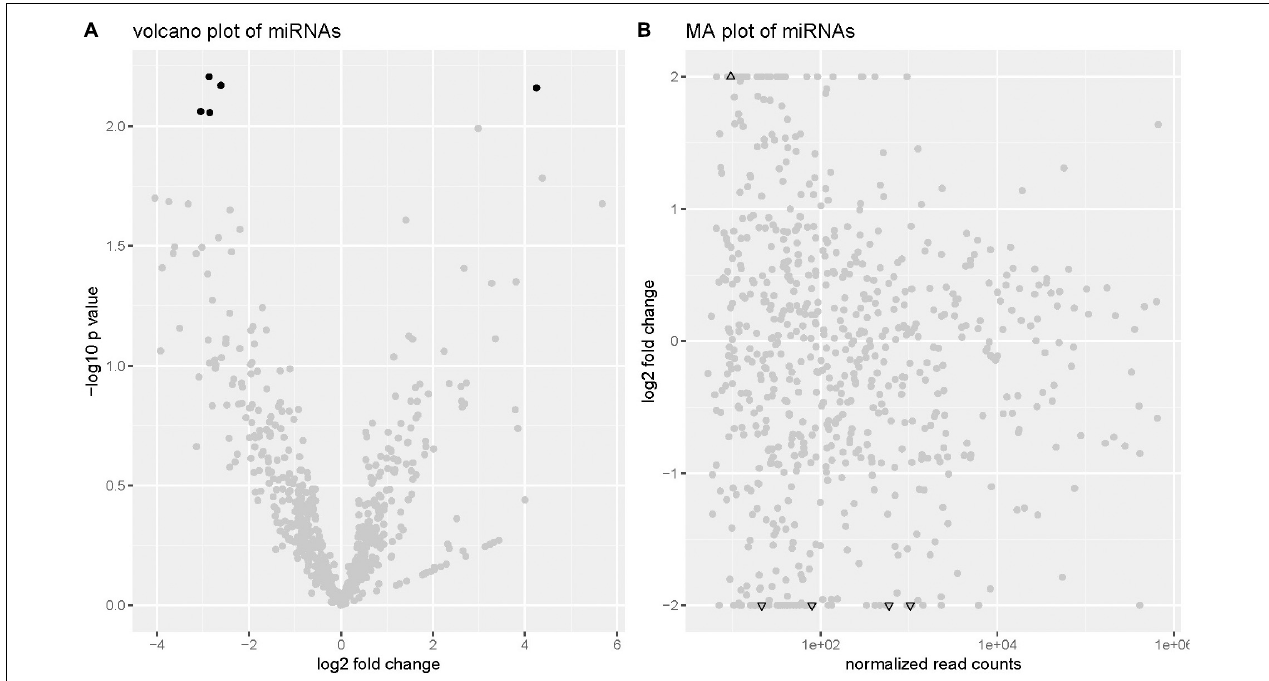
FIGURE 1 | The volcano plot and MA-plot of expressed miRNAs. (A) Volcano plot. Significantly DE miRNAs are in black. Others are in gray. (B) MA plot. When the LFC of the DE miRNAs were greater than 2 or less than –2, they were presented by black triangles on the boundary.